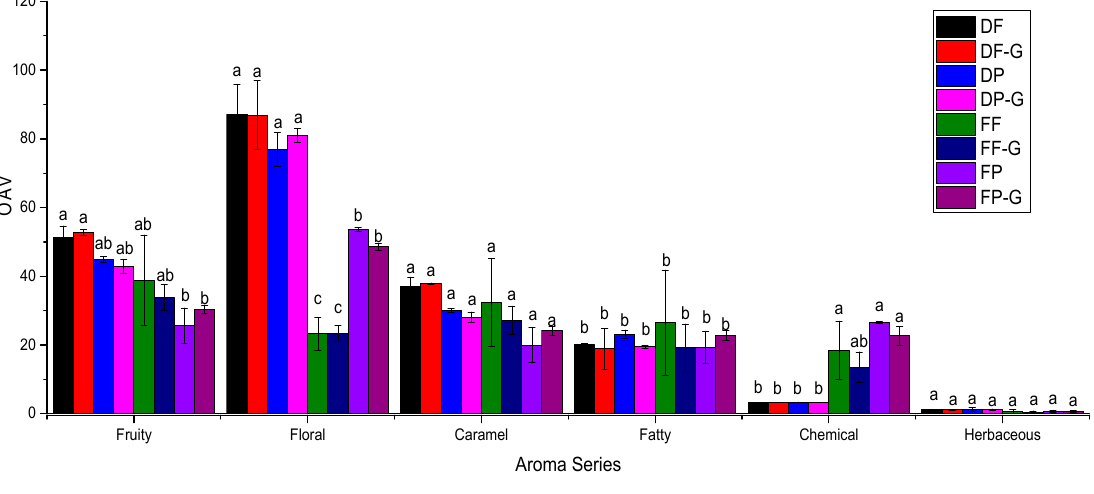
Figure 2. Total OAV value in each aroma group in goji berry fermented wine. The OAV value is calculated by summing up the OAV value of volatile in each aroma group. Different letters indicate significant difference of these wines in each aroma group at p ≤ 0.05 of aroma series of goji wines.